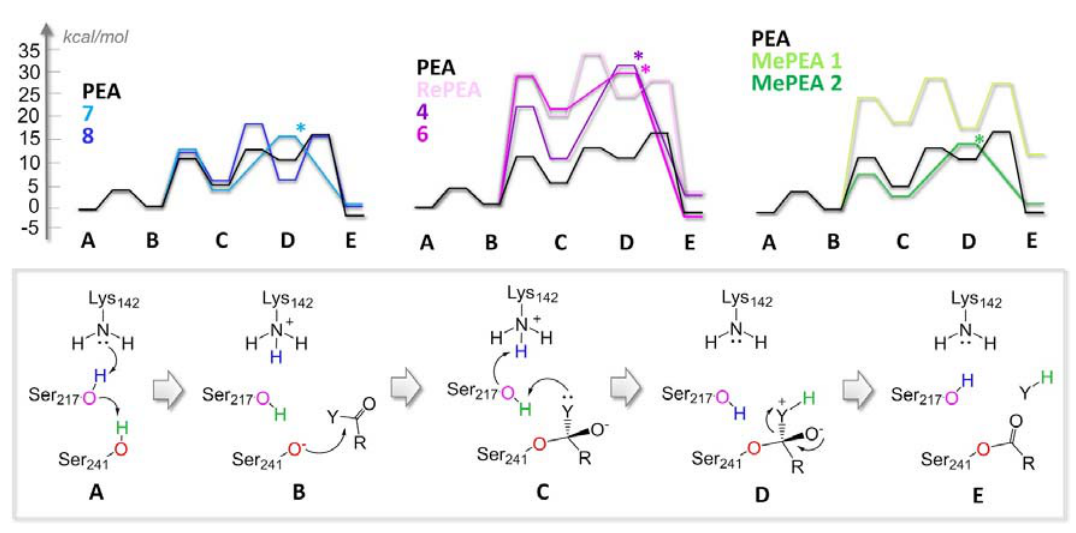
Figure 4. Top: energy profiles (kcal/mol) associated with the FAAH acylation phase of hydrolysis of PEA-like ligands (left blue shades), RePEA-like ligands (middle, purple shades), and MePEA ligands (right, green shades). The PEA hydrolysis profile (black lines) has been taken as a reference for each plot. If present, “*” indicates a concerted elementary reaction step from C to E (i.e., without passing through the formation of D. Bottom: reaction mechanism corresponding to the calculated energy profiles.